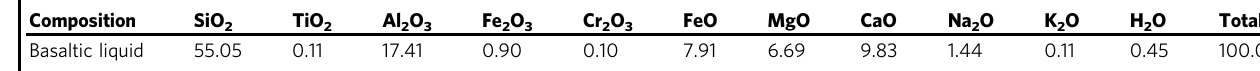
Table 1 Composition of basaltic liquid used for alphaMELTS modelling at a pressure range from 1 to 10 kbar Composition SiO 2 Basaltic liquid